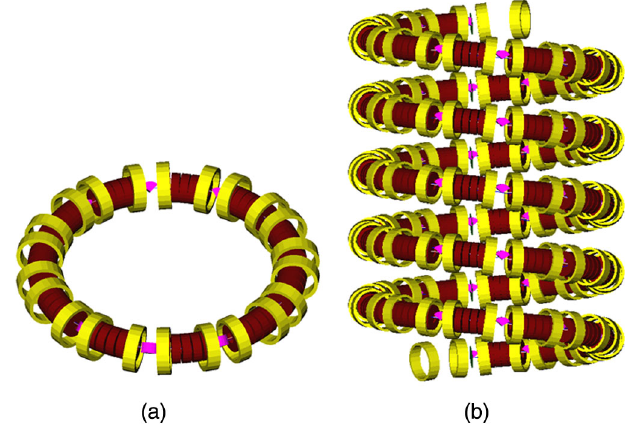
FIG. 1. (a) Drawing of an idealized RFOFO cooling ring; (b) 5 turn slice of a Guggenheim helix. The large yellow cylinders are solenoids, the small red cylinders are the active volume of the rf cavities, and the magenta wedges are hydrogen absorbers.